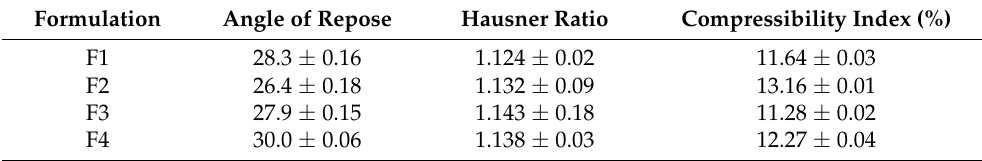
Table 2. Results of flow characteristics.